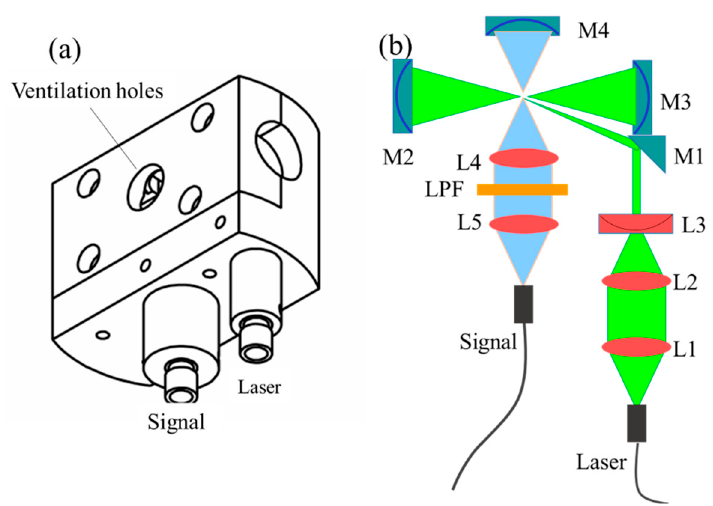
Figure 2. Schematic of the multi-reflection cavity probe design. ( a ) Structure drawing of high-sensitivity Raman gas probe; ( b ) the schematic of high-sensitivity Raman gas probe.